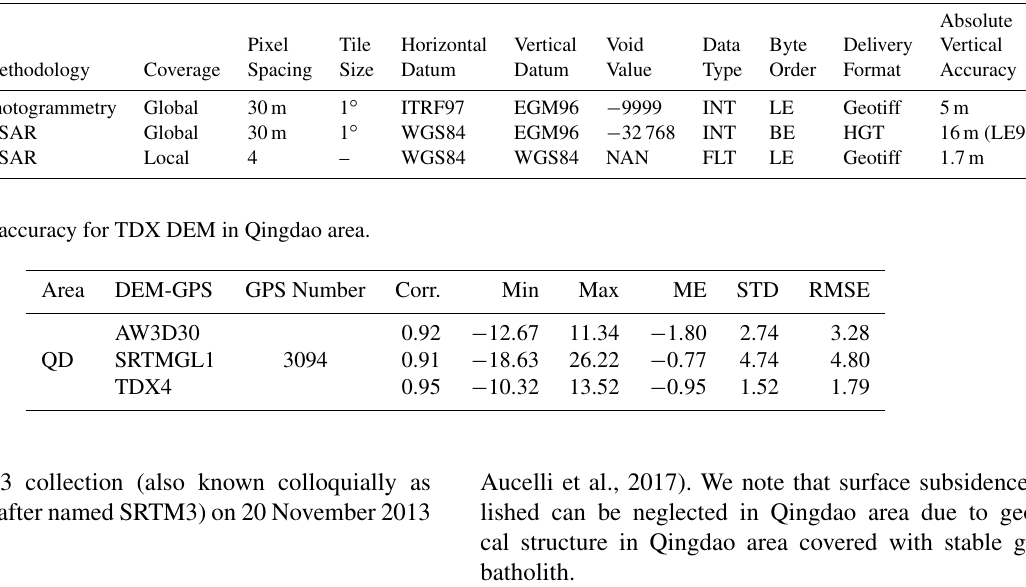
Table 1. Specifications of the DEMs used in this study.